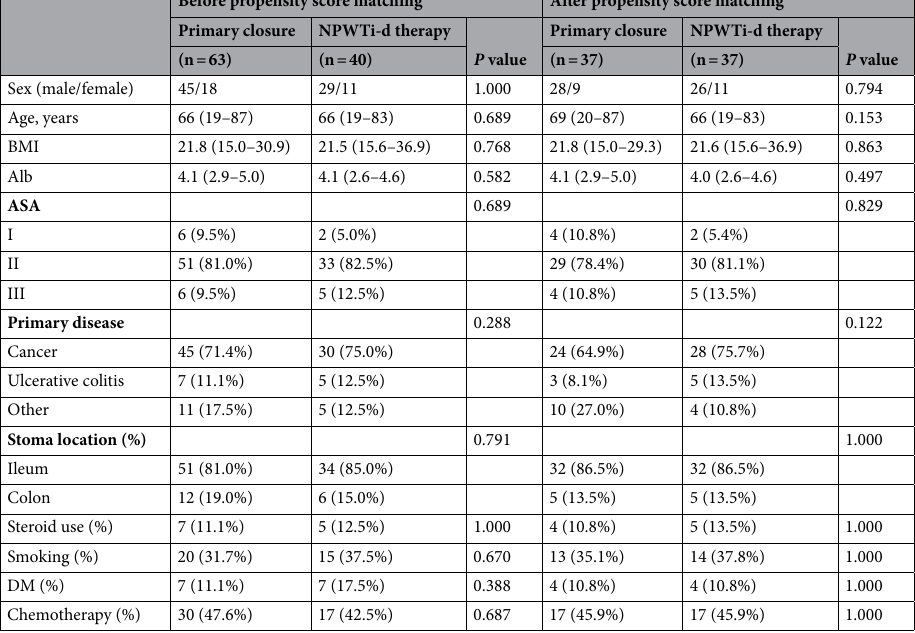
Table 1. Characteristics of the patients before and after propensity score matching. BMI , Body mass index; Alb , Albumin; ASA , American Society of Anesthesiologists; DM , diabetes mellitus, NPWTi-d , negative pressure wound therapy with instillation and